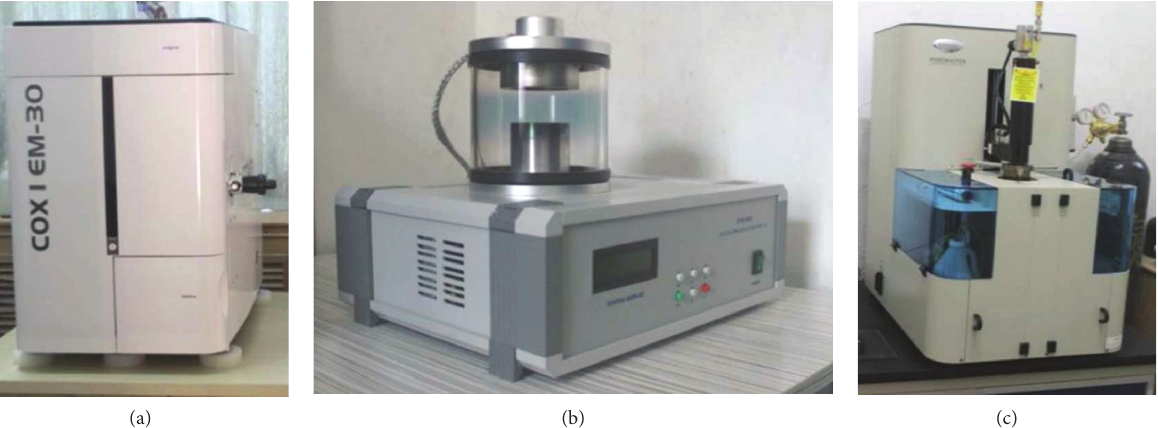
Figure 5: Microscopic test instruments: (a) scanning electron microscope; (b) ion sputtering apparatus; (c) automatic mercury injection apparatus.